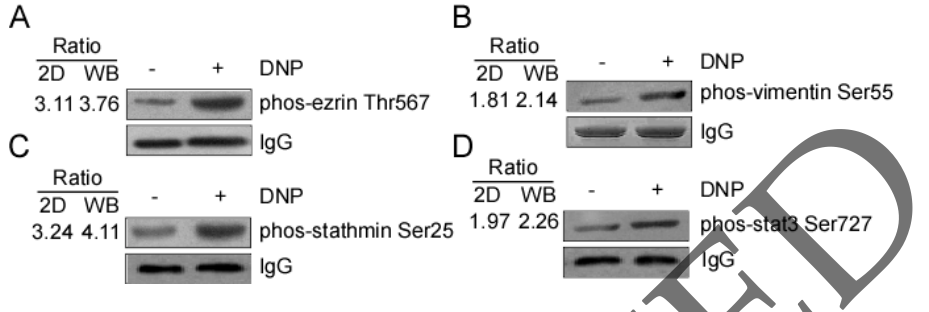
Figure 5. DNP induces motility and invasion through ezrin phosphorylation. ( A ) 6-10B cells were transfected using pcDNA3.1, pcDNA3.1-ezrin or the pcDNA3.1-ezrin mutant. Ezrin and phospho-ezrin were detected with Western-blotting analysis; the invasion ( B ) and motility ( C ) were detected in 6-10B-mock, 6-10B-ezrin and 6-10B-ezrin mutant cells with or without DNP treatment. Data are presented as means ± SD from three independent experiments. Results were analyzed by one-way ANOVA with post-hoc Dunnett’s test ( * , p <